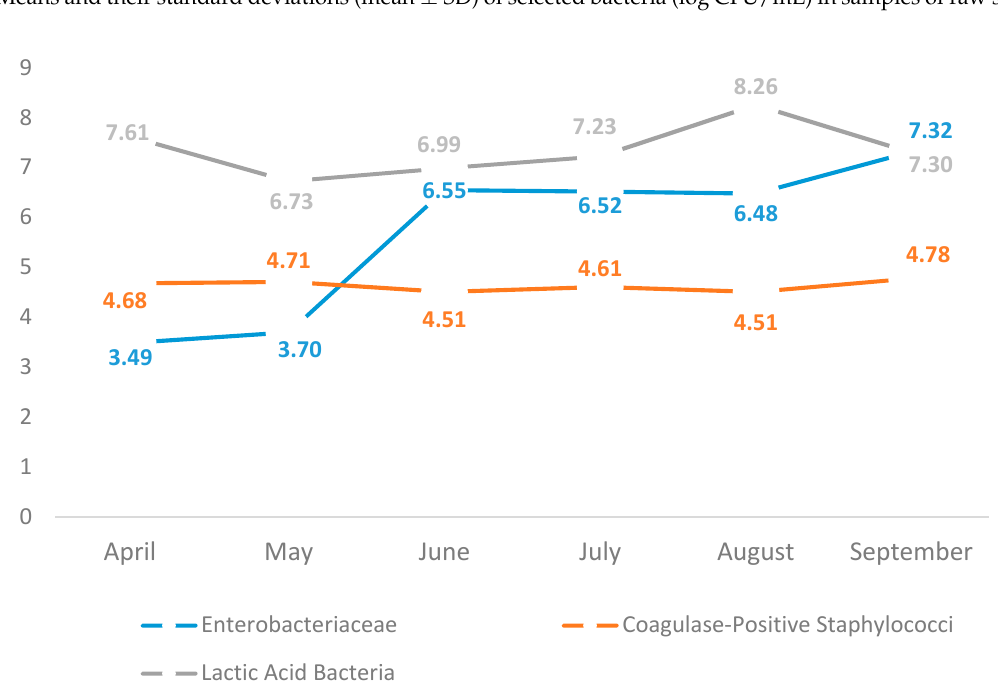
Figure 3. Means and their standard deviations (mean ± SD) of selected bacteria (log CFU/mL) in samples of raw goat milk.